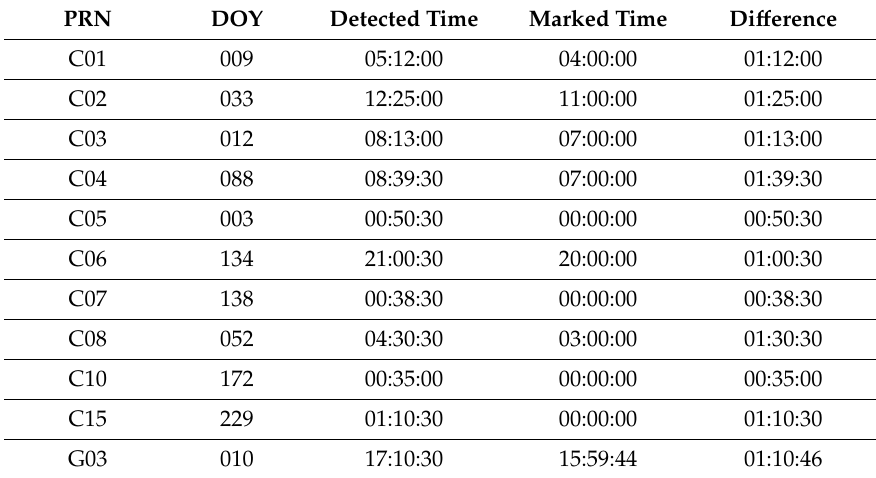
Table 4. Results of orbital maneuver detection for the BeiDou Navigation Satellite System (BDS) GEO / IGSO and GPS MEO satellites (unit: